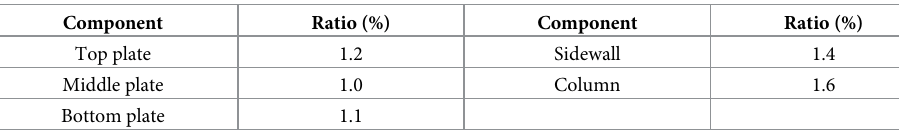
Table 2. Reinforcement ratio of the underground